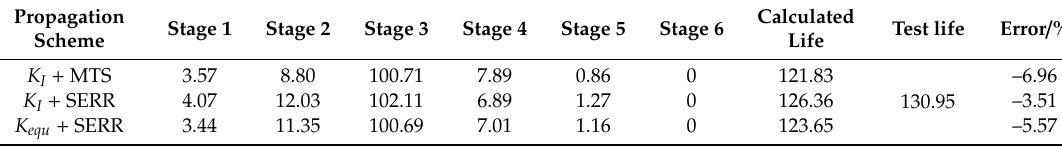
Table 5. Fatigue life of di ff erent stages ( × 10 4